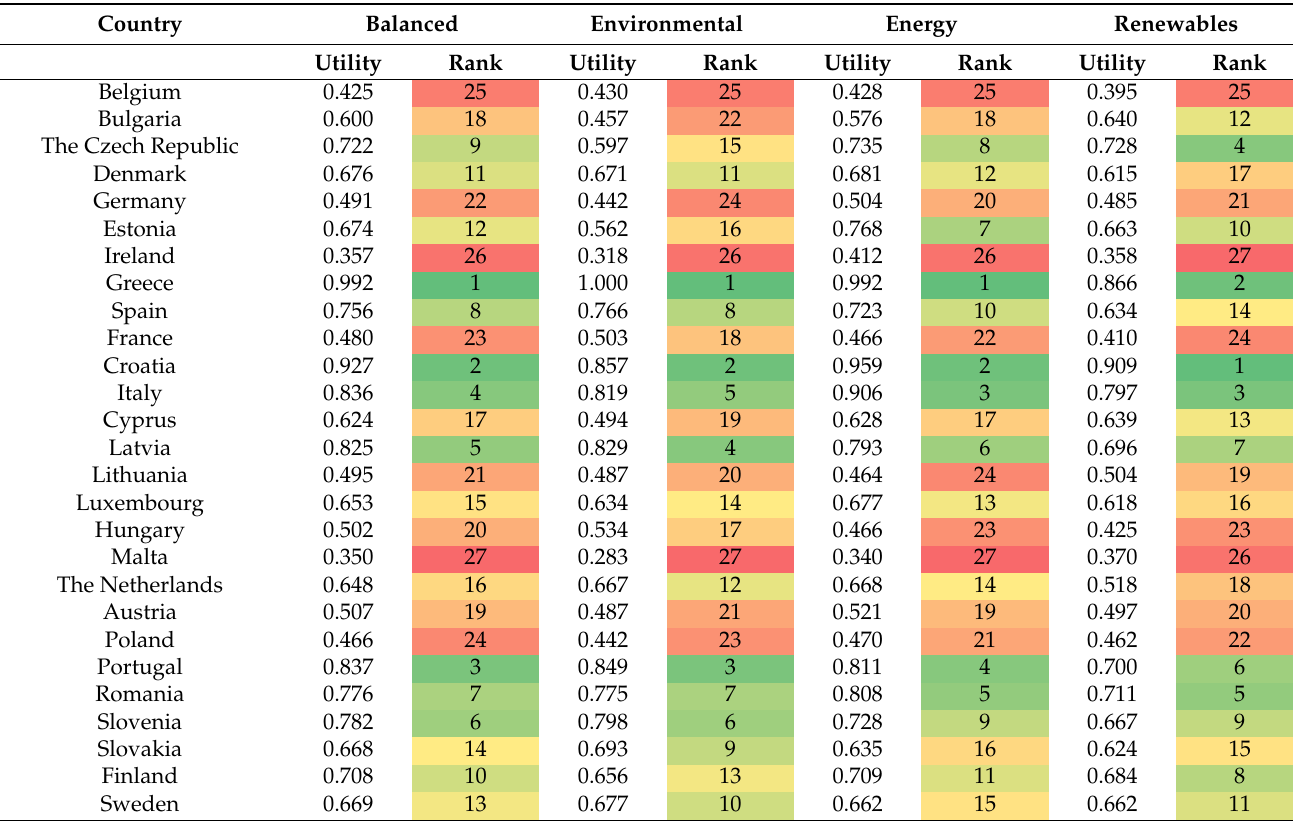
Table 5. Results of the KerCA analysis for the EU countries.